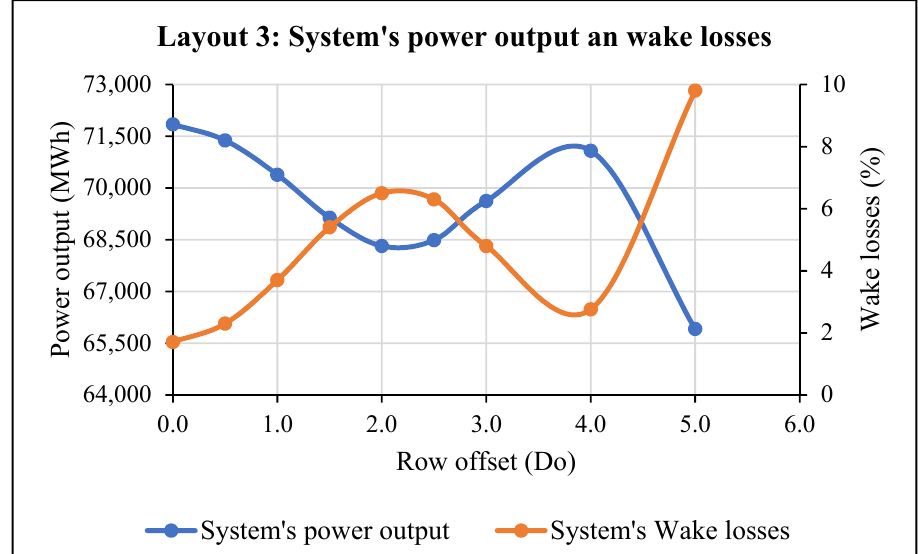
Figure 19. System’s power output for different row offset.